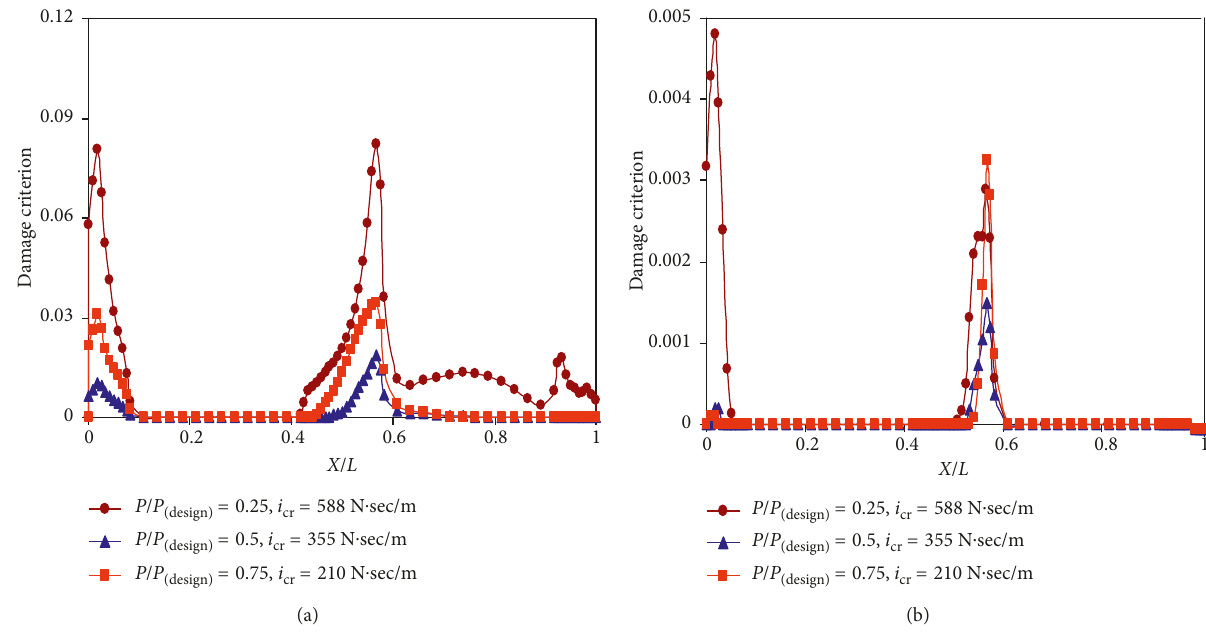
Figure 16: Damage initiation criterion profile of propped cantilever column W150 of the tension flange; (b) at the middle of the web.